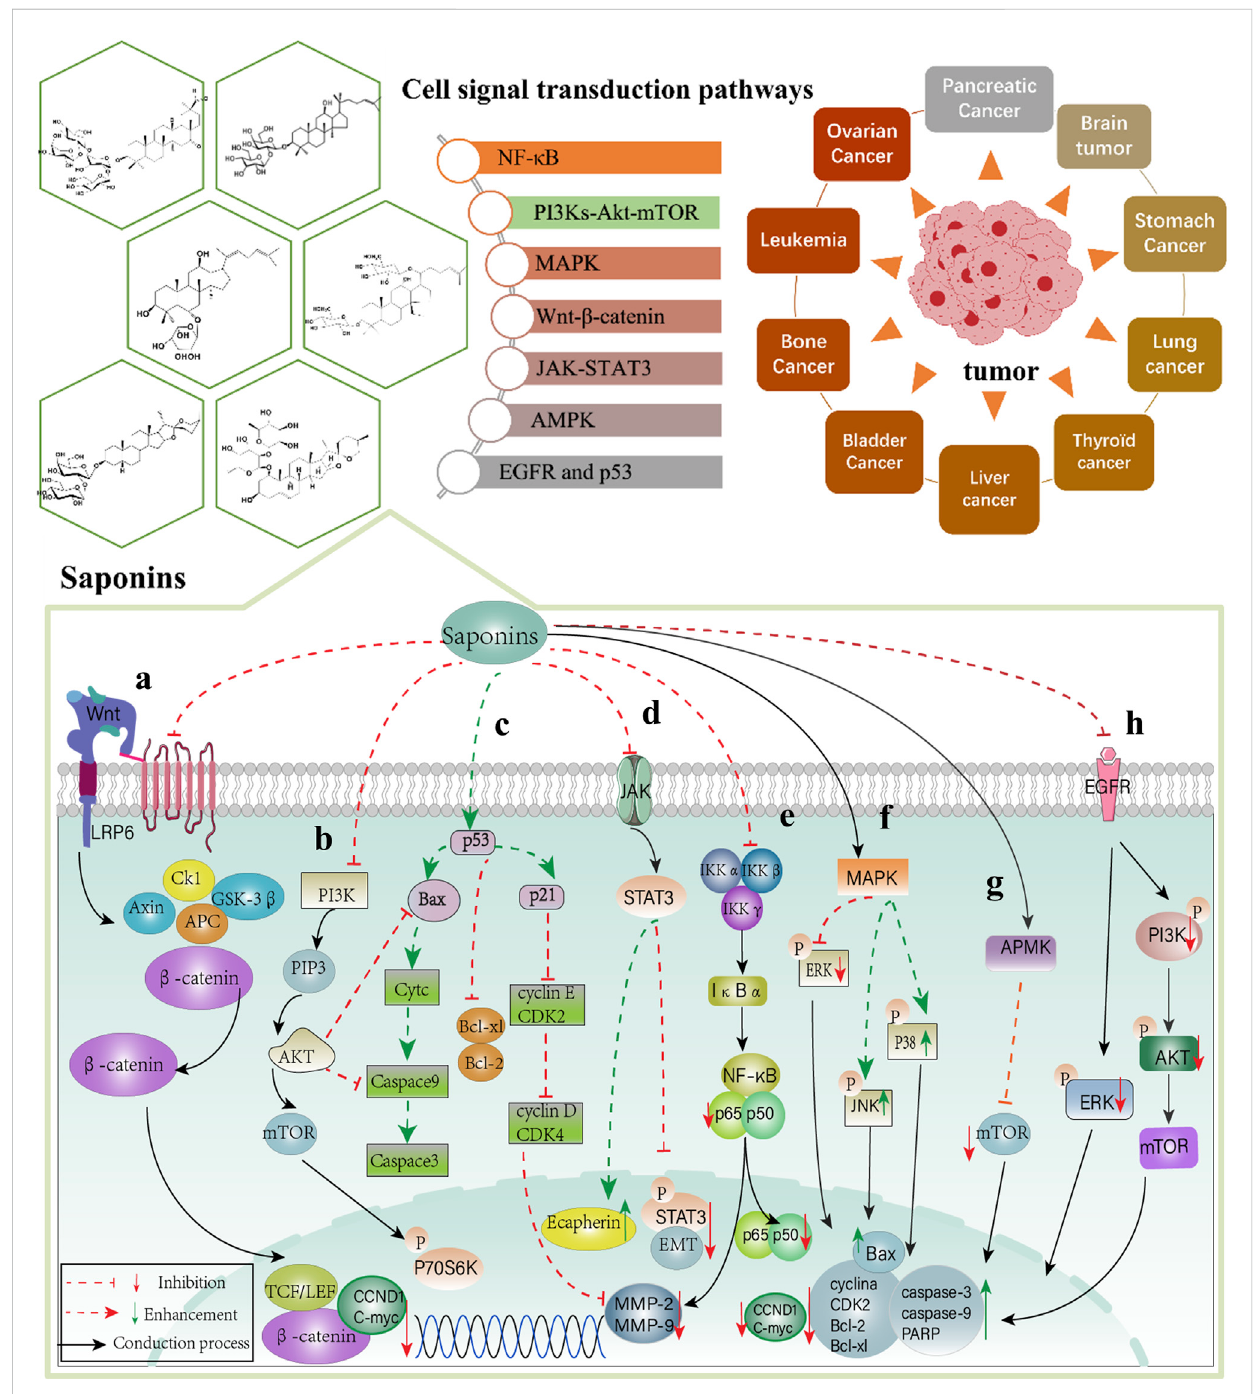
FIGURE 3 Signaling pathway of Chinese materia medica saponins in anti-cancer effect. (A) Wnt- β -catenin; (B) PI3Ks-Akt-mTOR; (C) p53; (D) JAK-STAT3; (E) NF- κ B; (F) MAPK; (G) APMK and (H) EGFR signal transduction pathway.